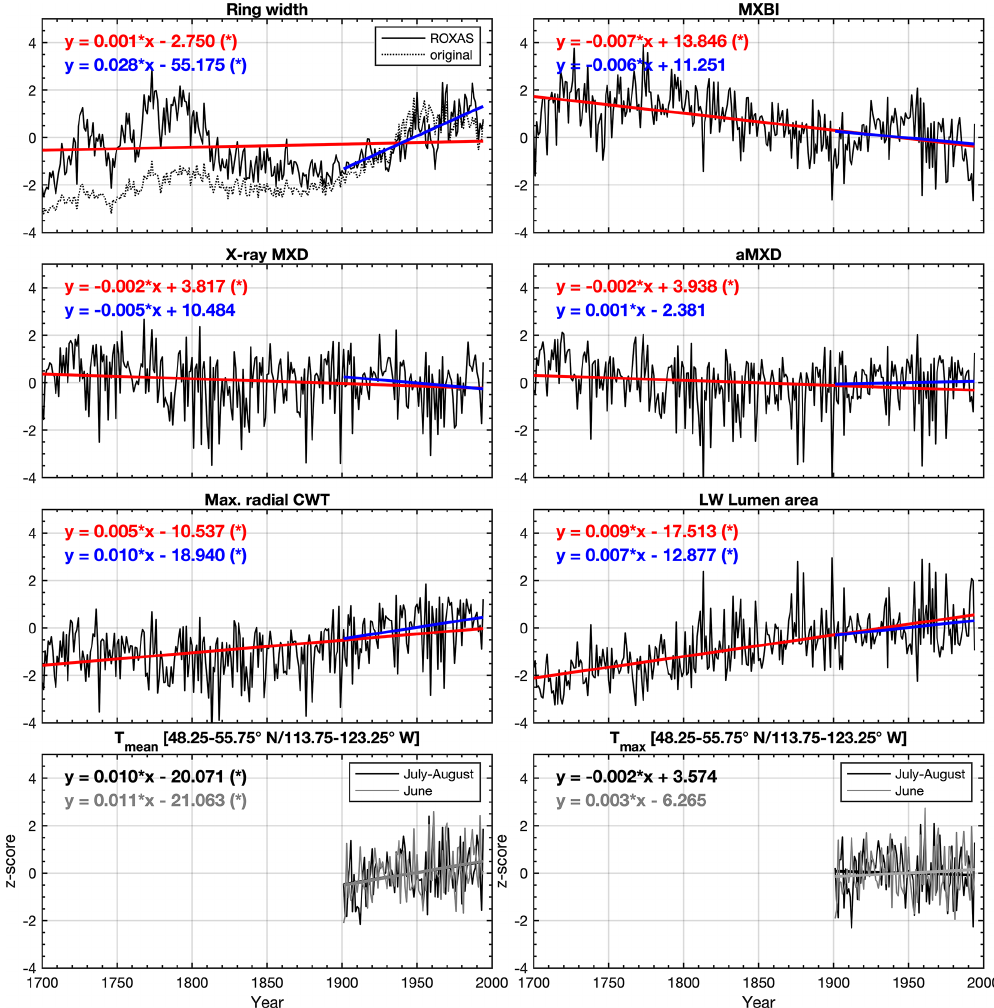
Figure 2. Average non-detrended time series of selected tree ring parameters, z -scored over the 1901–1994 reference period. The blue and red lines show the linear trends over the 1901–1994 and 1700–1994 periods, respectively. Seasonally averaged June–August (48.25– 55.75 ◦ N/113.75–123.25 ◦ W CRU TS v4.03 subset average) mean ( T mean ) and maximum ( T max ) temperatures are provided for comparison. ∗ significant trend ( α = 0 . 05) estimated by the Mann–Kendall trend detection test. LW latewood, CWT cell wall thickness, aLWD anatomical latewood density and aMXD anatomical maximum latewood density. See Fig. S4 for full 1586–2015CE period